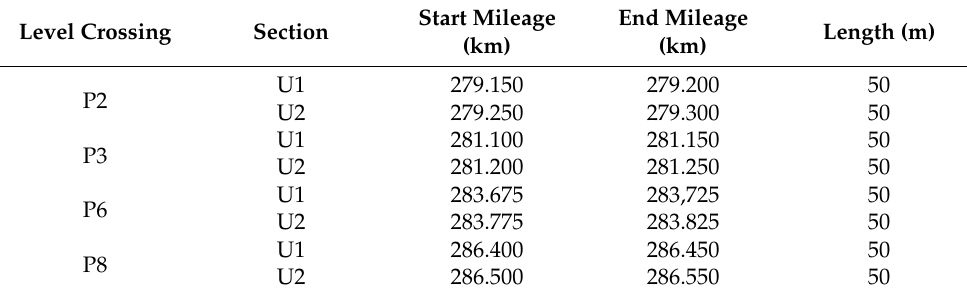
Figure 2. Surveyed railway level-crossings displayed on the map (mapy.cz overlay). Table 2. Survey sections stationing and